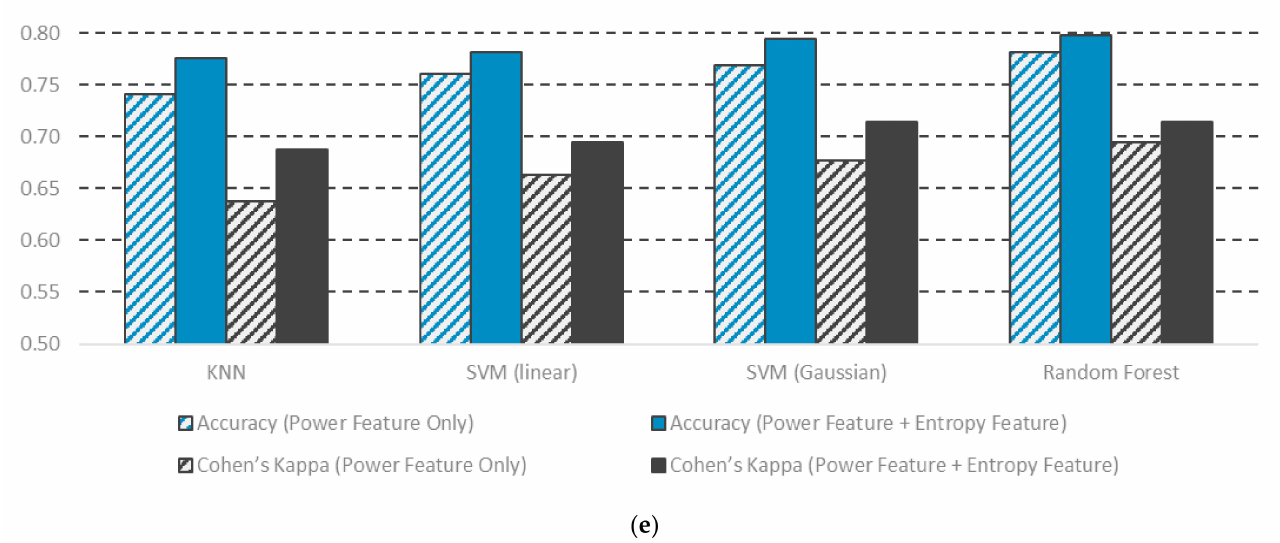
Figure 3. Classification results of the Reference dataset. ( a ) Confusion matrix of the training split (F3 channel). All classes except N1 showed accuracy above 0.75; ( b ) confusion matrix of testing split (F3 channel). The accuracies of each class were nearly identical to that of the training split; ( c ) confusion matrix of training split (F4 channel); ( d ) confusion matrix of testing split (F4 channel); ( e ) accuracy and Cohen’s Kappa for the old feature set (power features only) and for our current feature set (power + entropy features) in various classifiers.